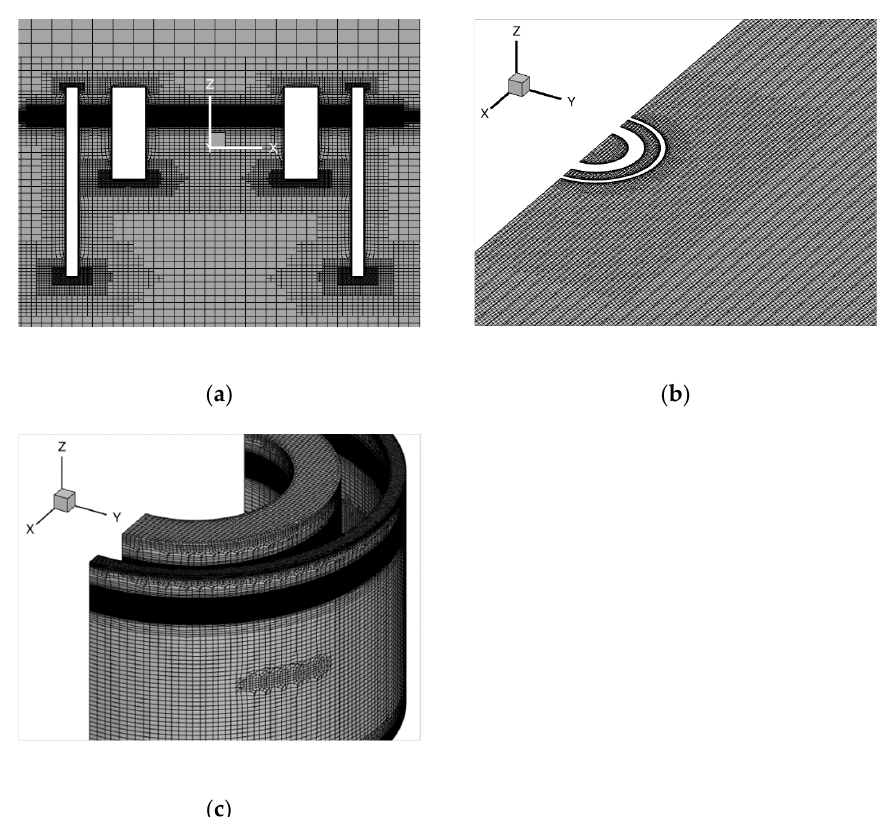
Figure 3. Computational mesh used for the CFD simulations, in case of Configuration 1. The mesh of the Configuration 2 has the corresponding characteristics; ( a ) symmetry plane; ( b ) z plane cut; ( c ) surface mesh.